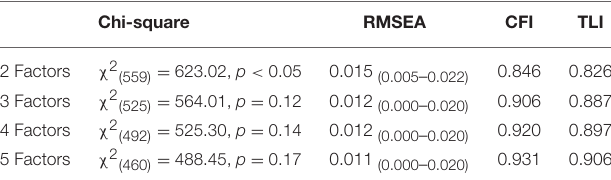
TABLE 1 | Study 1: Exploratory factor analysis fit indices for the two to five-factor solutions. Chi-square